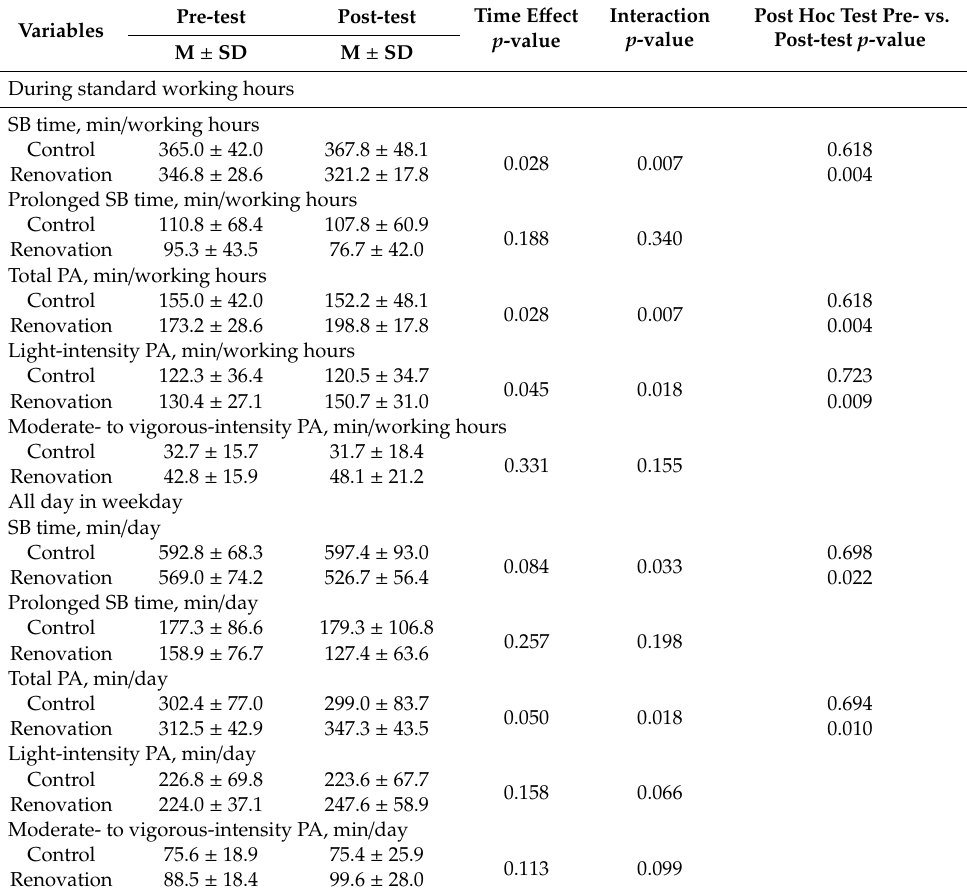
Table 2. Changes in sedentary behavior and physical activity from pre- to post-test in each group.